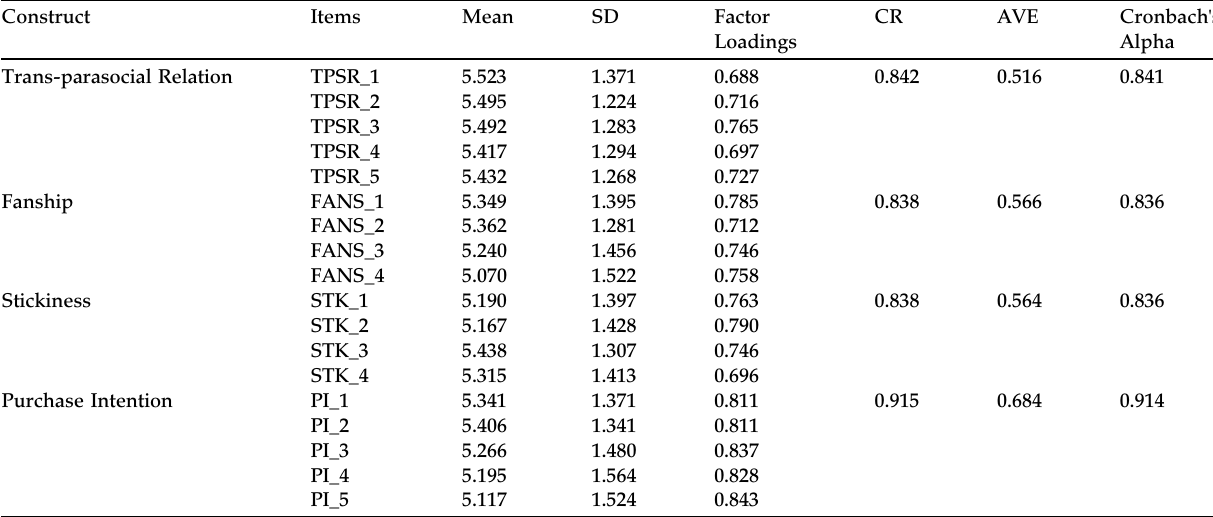
Table 3. Results of reliability and validity. Construct